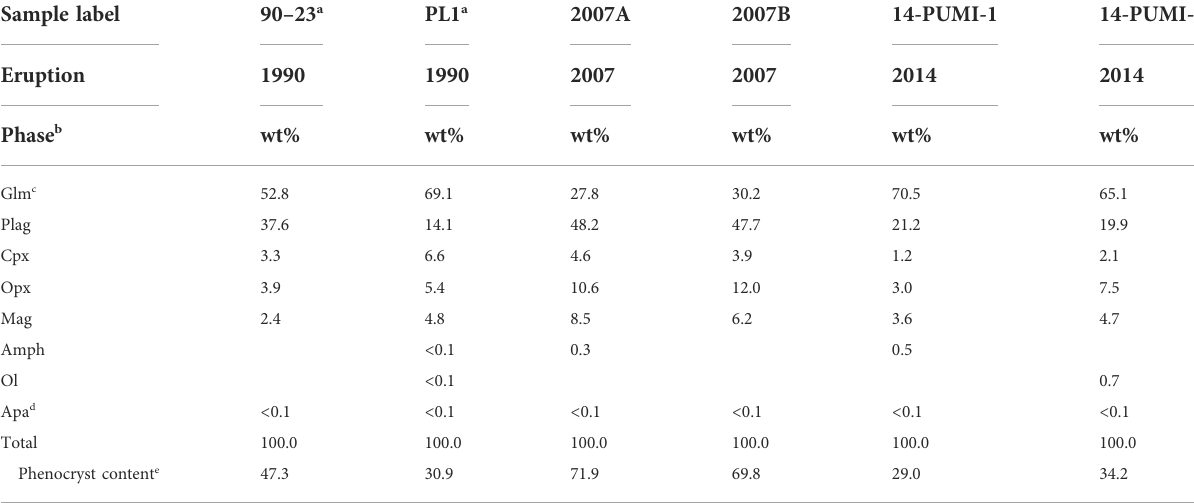
TABLE 2 Mineral assemblage and phenocryst content of samples from 1990, 2007, and 2014 eruptions. Sample